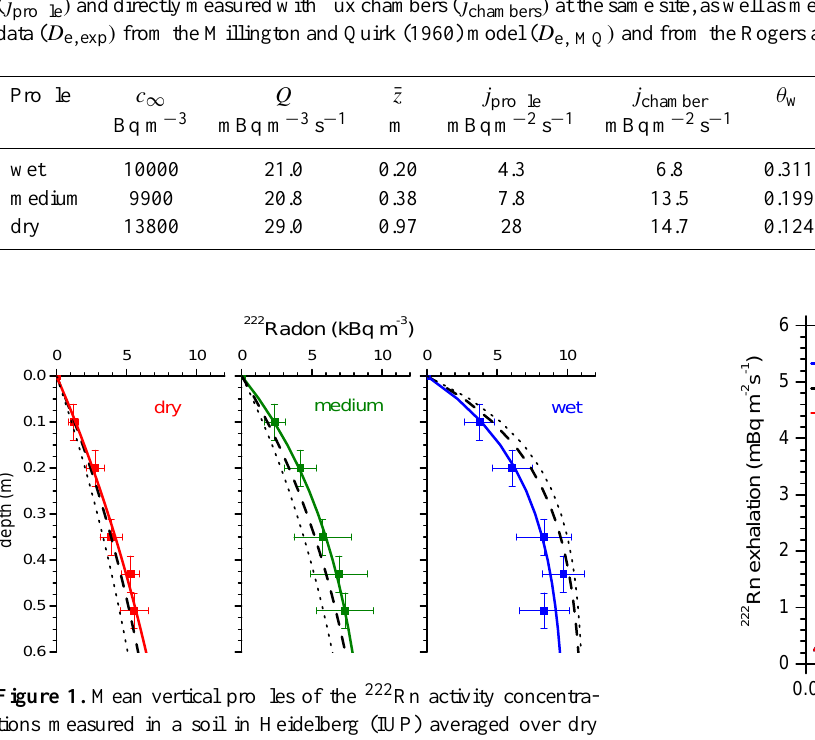
Figure 2. Dependency of the 222 Rn exhalation rate on water-table depth; the solid lines are calculated according to Eq. (8a) with Q = 12mBqm − 3 s − 1 and different effective diffusivities, i.e. different relaxation depths ¯ z( = z q )